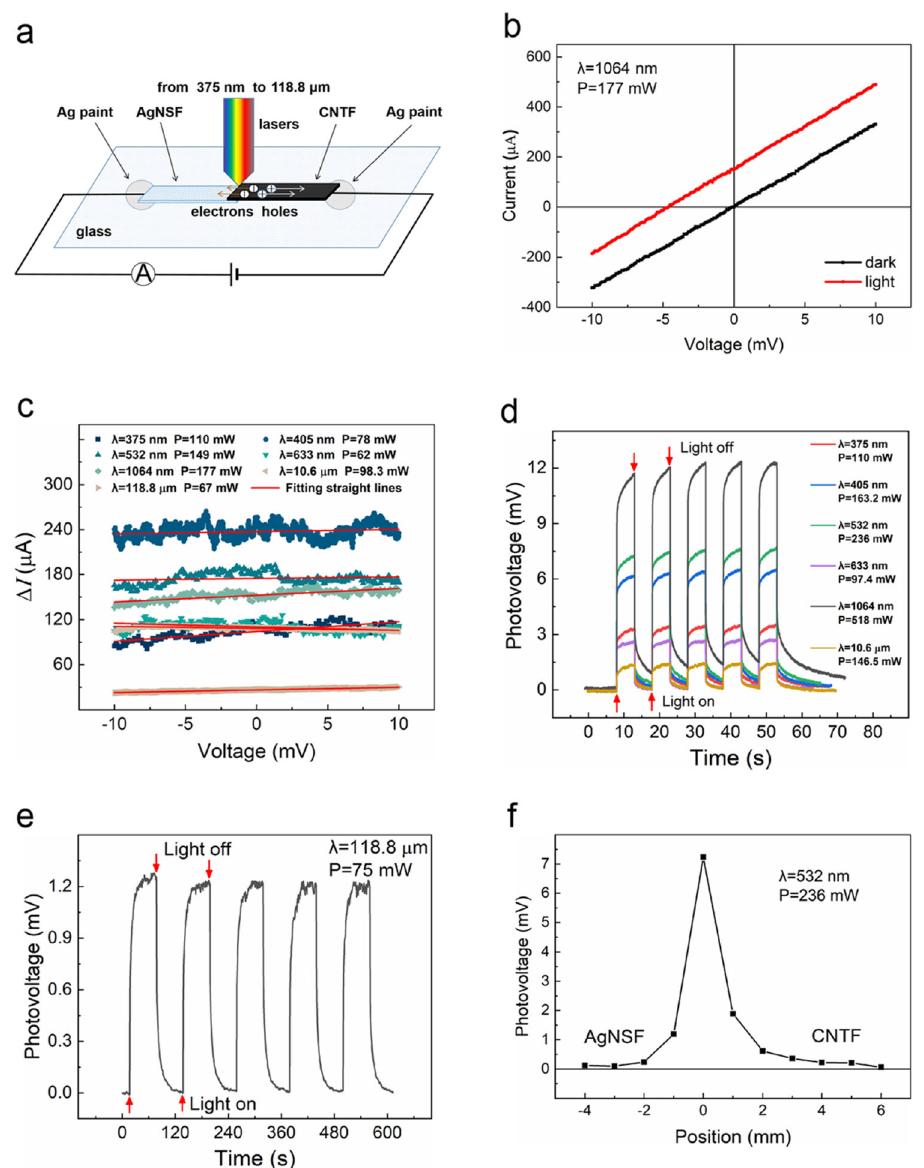
Fig. 3 Photoelectric performance. a Schematic diagram of the device used to measure the I – V curves of the sample. b I – V curve when the heterojunction irradiated by a laser with wavelength of 1064 nm. c Δ I – V curves of the heterojunction irradiated by lasers with wavelengths ranging from 375 nm to 118.8 μ m. Photovoltage – time response curves of the AgNSF/CNTF sample irradiated by lasers with wavelengths of d 375 nm, 405 nm, 532 nm, 633 nm, 1064 nm, 10.6 μ m and e 118.8 μ m, respectively. f Photovoltage – position curve obtained when different positions of the sample were irradiated by a laser with wavelength of 532 nm and power of 236 mW, in which the position 0 mm is the central position of the